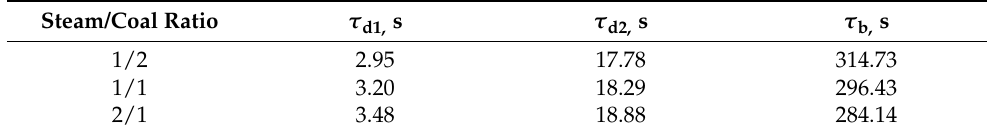
Table 2. Effect of steam content on the temporal characteristics of combustion.